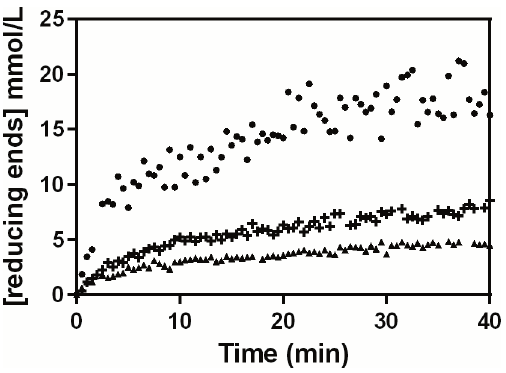
Figure 3. Reaction profiles obtained over the first 40 min with different initial pectin concentrations. The hydrolysis was per- formed at 45 u C, with the pectinase complex produced by Aspergillus N niger CH4 in solid-state fermentation. Symbols: Initial pectin concen- ) 1% m/v. trations of ( m ) 0.25% m/v, ( + ) 0.5% m/v and (